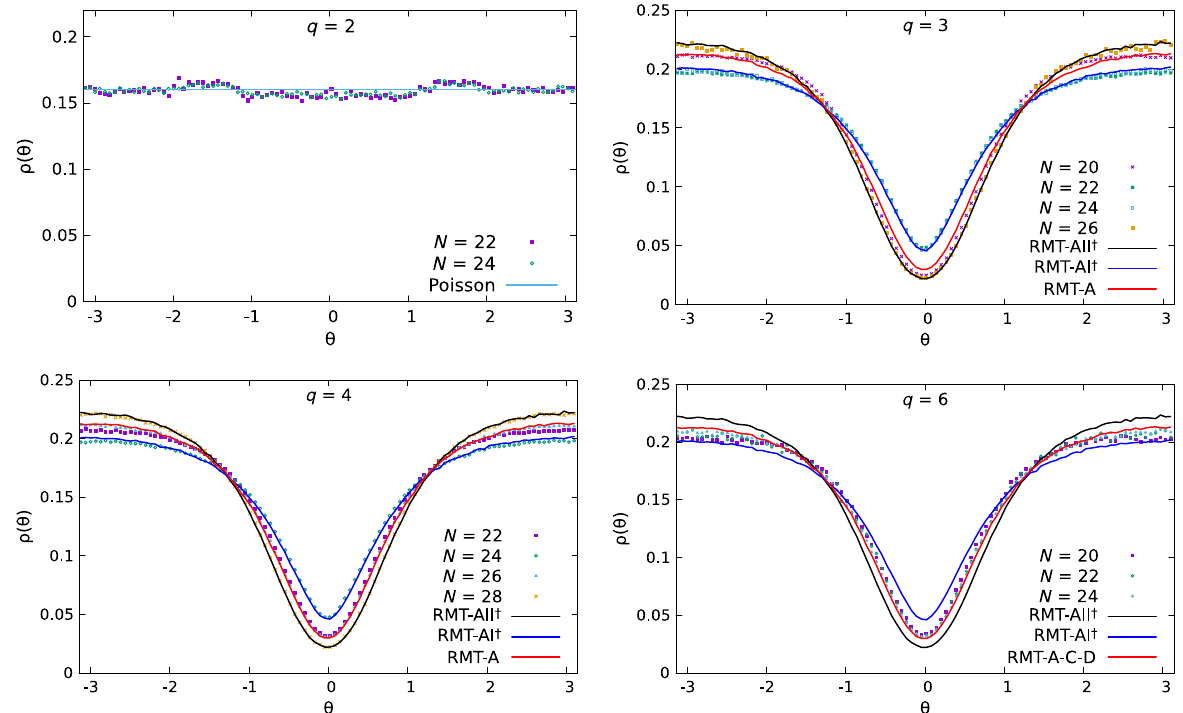
FIG. 7. Angular density of the complex spacing ratio related to the eigenvalues of the nHSYK Hamiltonian Eq. (17) for different values of N and q . We see agreement with the predictions of Table II in all cases.